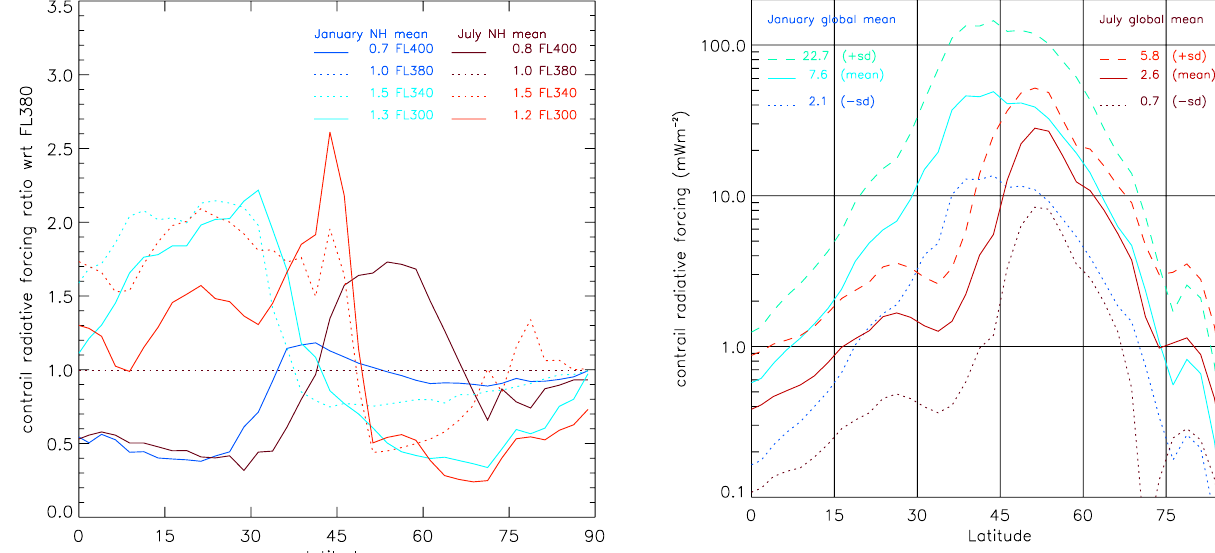
Fig. 6. January and July zonal net RF ratio for the cruise altitudes shown in Fig. 5 with respect to FL380. The numbers show the NH average.